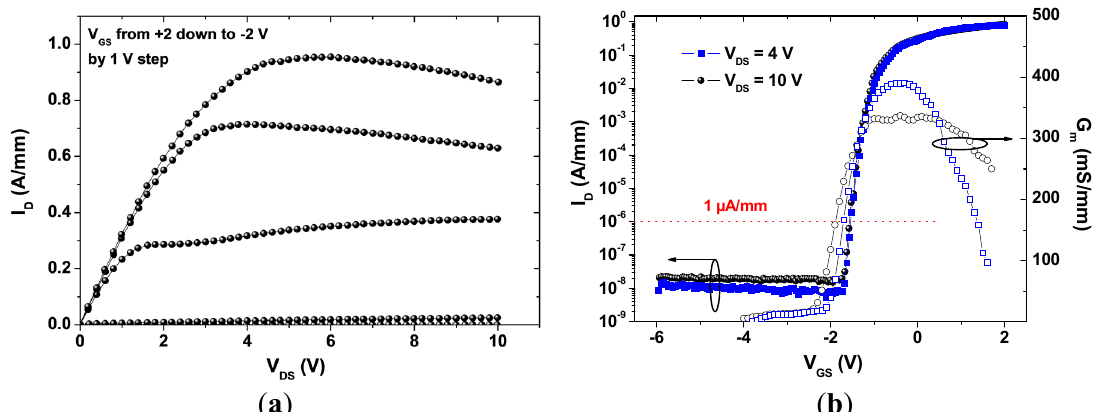
Figure 2. ( a ) DC output I D -V DS characteristics of a 2 × 25 µm AlN/GaN-on-Si HEMT. V GS swept from − 2 up to +2 V in 1 V steps; ( b ) Transfer characteristics of the 2 × 25 µm AlN/GaN-on-Si HEMT at various V DS (4 and 10 V) using L G = 0.12 µm.